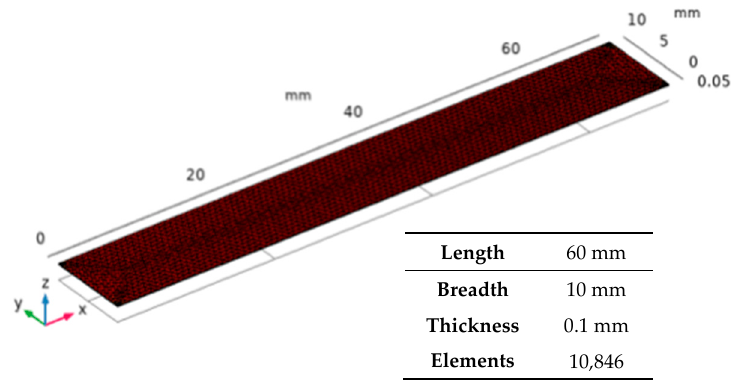
Figure 1. The thin film piezoelectric model (dimensions and mesh).